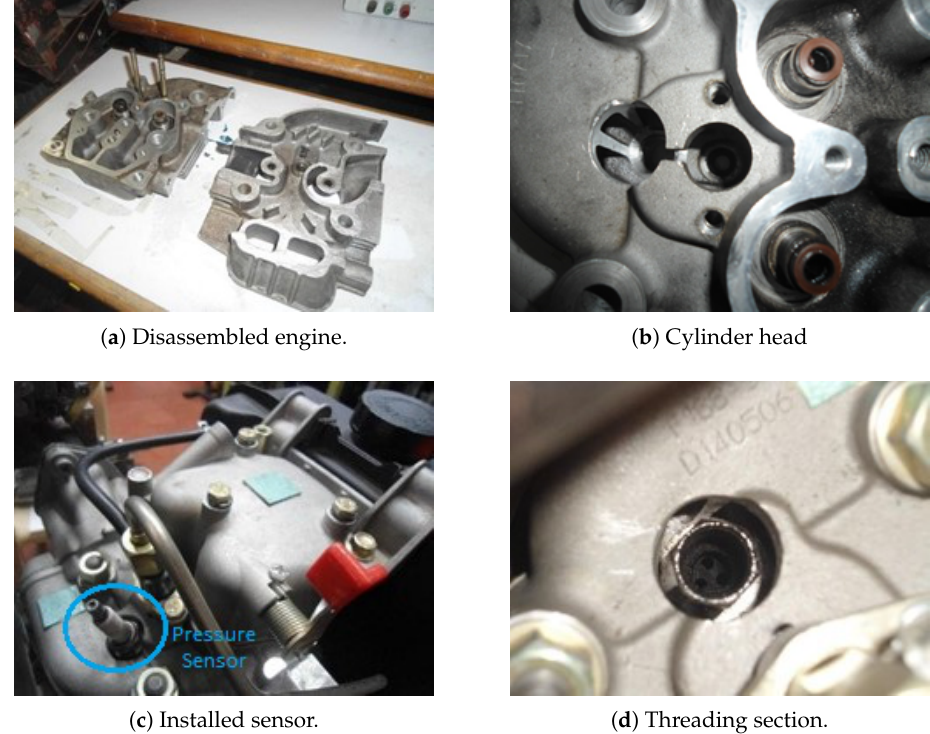
Figure 2. Pressure sensor implementation on a diesel-fueled CHANGFA 186 F single-cylinder engine.